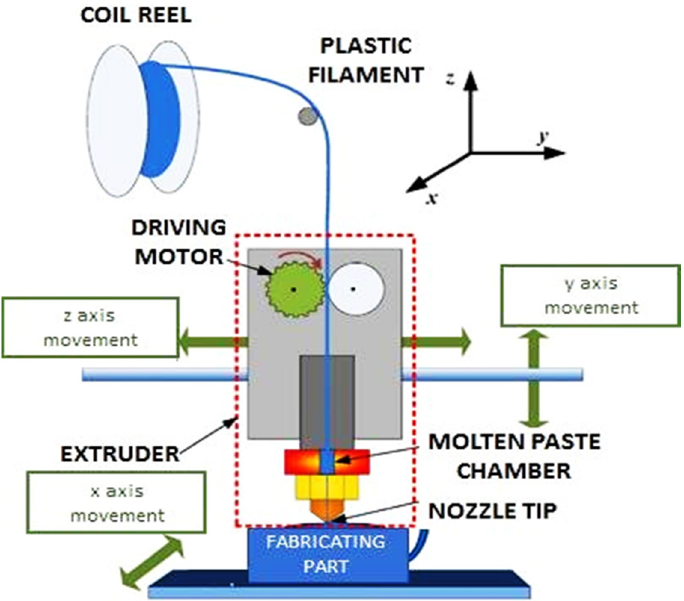
Figure 1. A diagrammatic representation showing the working of FDM/FFF 3D printing technology